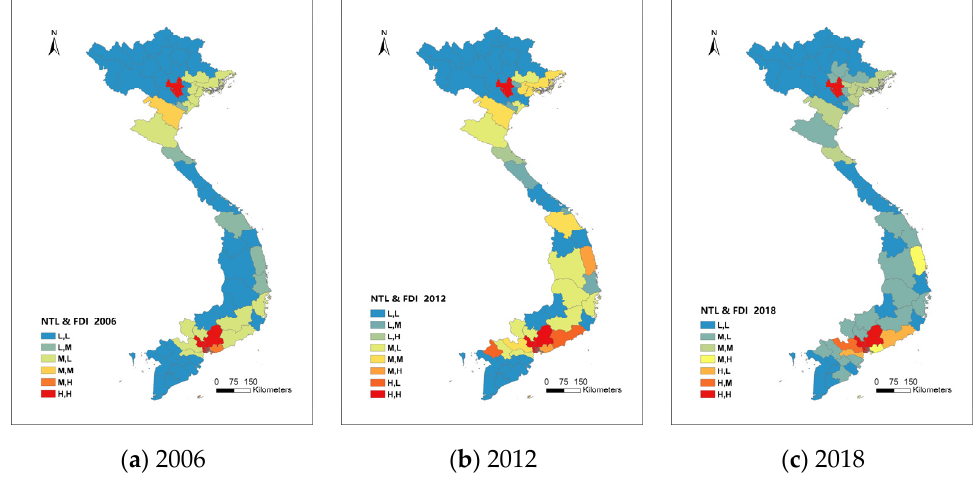
Figure 7. Changes in the coupling relationship between NTL-FDI from 2006 to 2018.